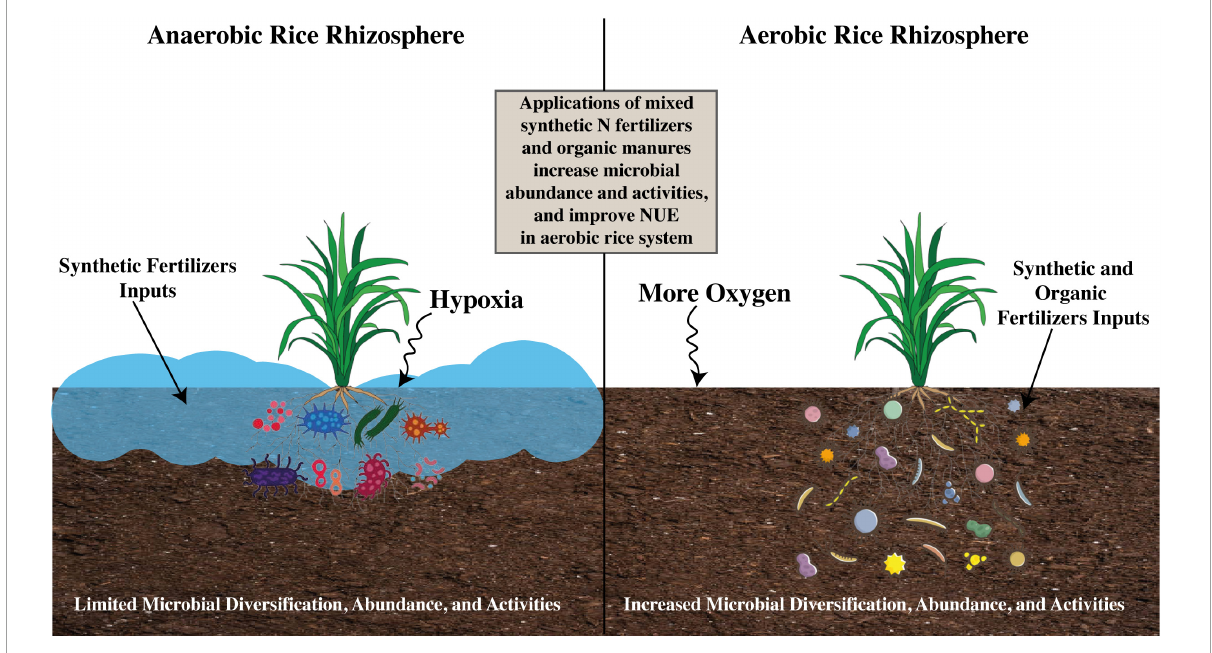
FIGURE5 Impact of soil management practices on microbial community abundance and activities under varying soil conditions (Rachwał et al., 2021; Wipf et al., 2021; Beule et al., 2022).